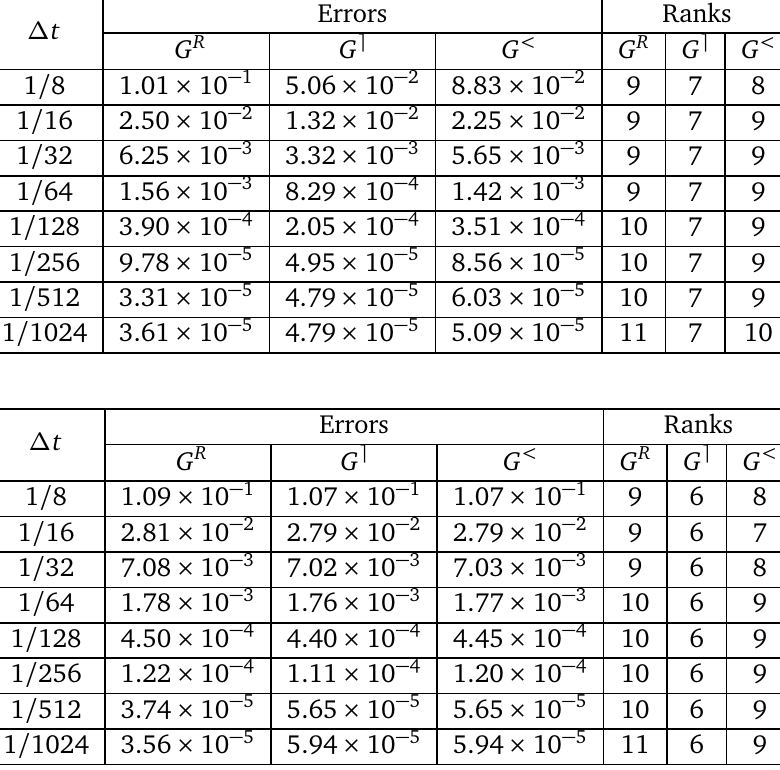
Table 3: Errors and ranks with a varying time step ∆ t and fixed propagation time T = 8, for the ramp (top) and Floquet (bottom) examples. Errors and ranks for each component are maximized over G and G 1 2